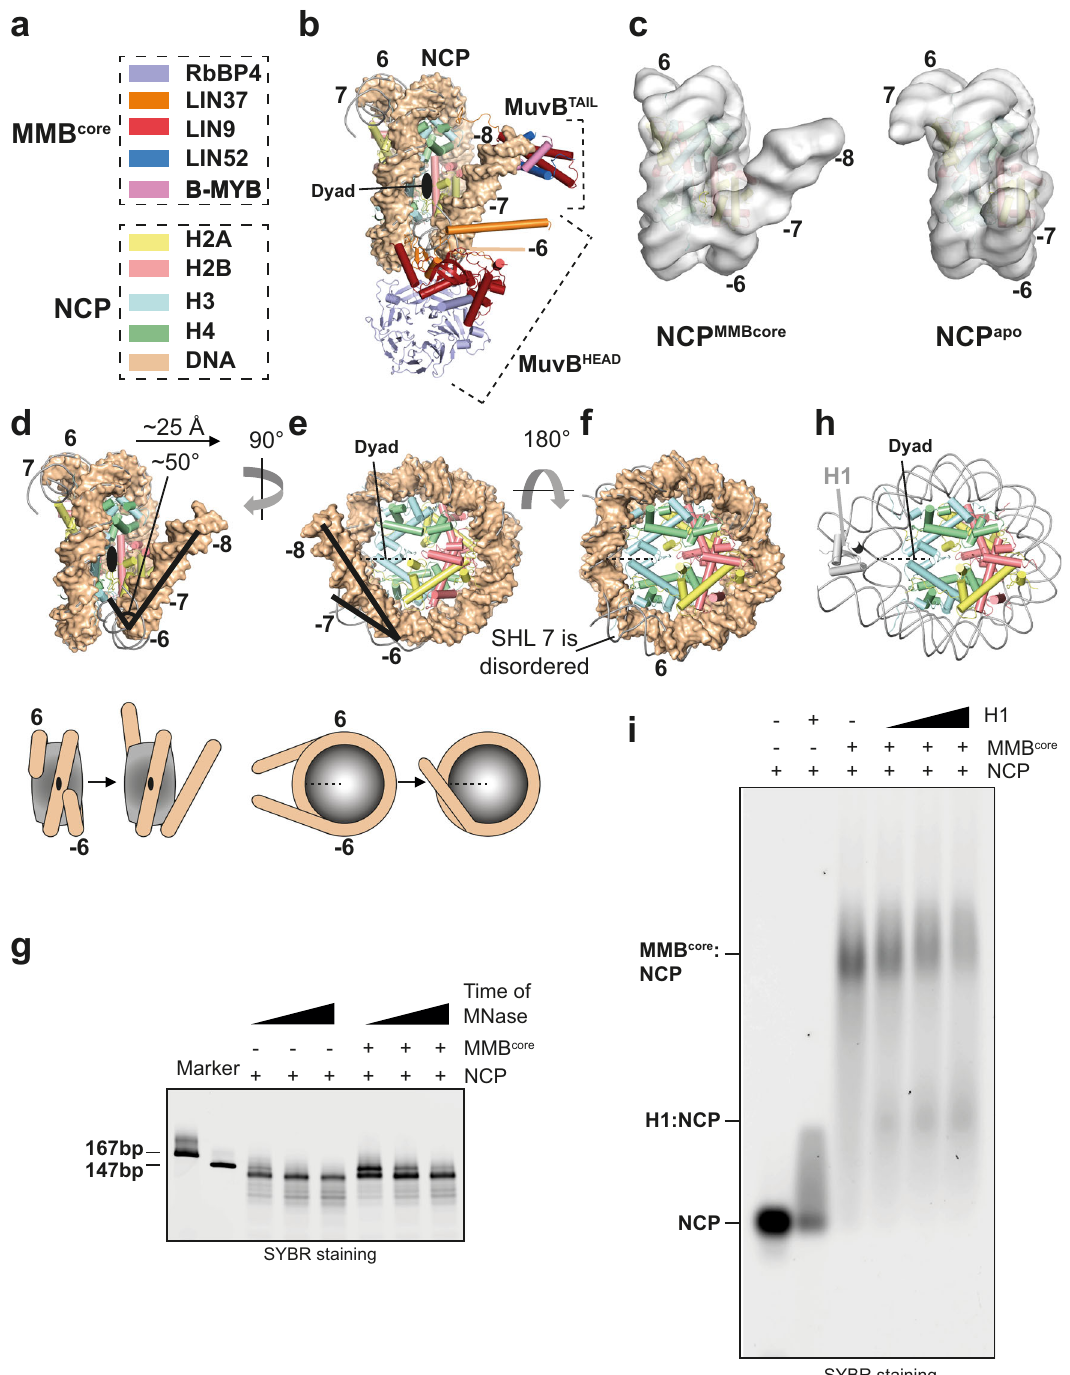
Fig.4|MMBinitiateschromatinremodelling.Detailsofdistortionsattheentry andexitDNAsites. DyadviewoftheMMB core :NCPstructureisshownin( b ),colour coded as speci fi ed in ( a ). The LIN9 CTD is not shown for visualising better the dis- torted nucleosomal DNA. c cryo-EM density is displayed for the NCP complex within either the MMB core :NCP (Supplementary Fig. 5g) or the apo NCP (Supple- mentary Fig. 4c). This comparison shows the conformational change at − /+7